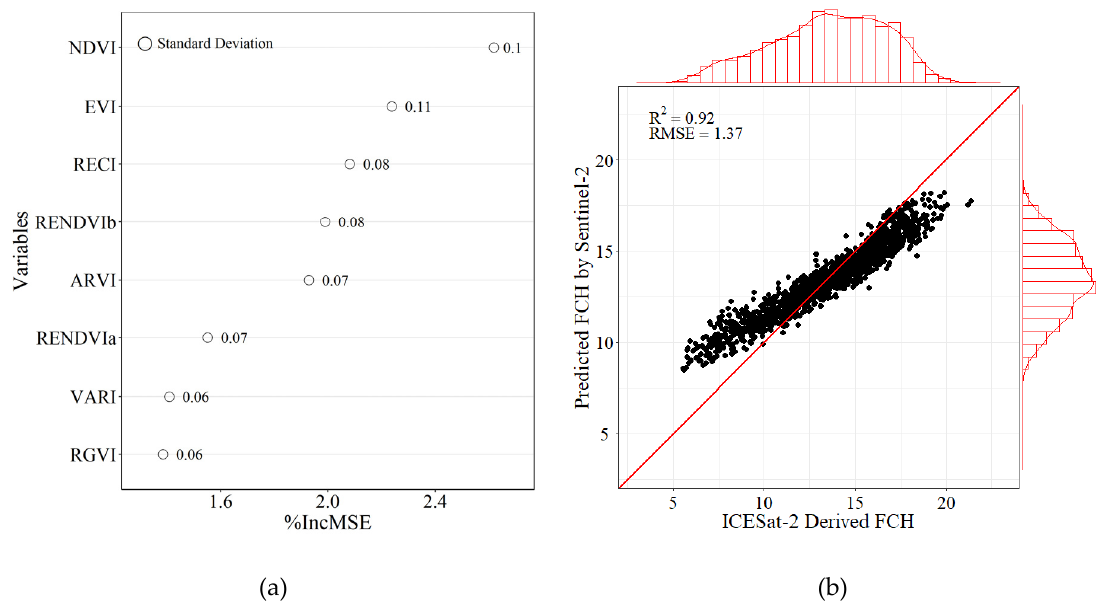
Figure 7. ( a ) Variable importance plot with standard deviations of the random forest analysis resulting from our stacking model; ( b ) scatterplot of forest canopy height estimates from ICESat-2, and those predicted from Sentinel-2.